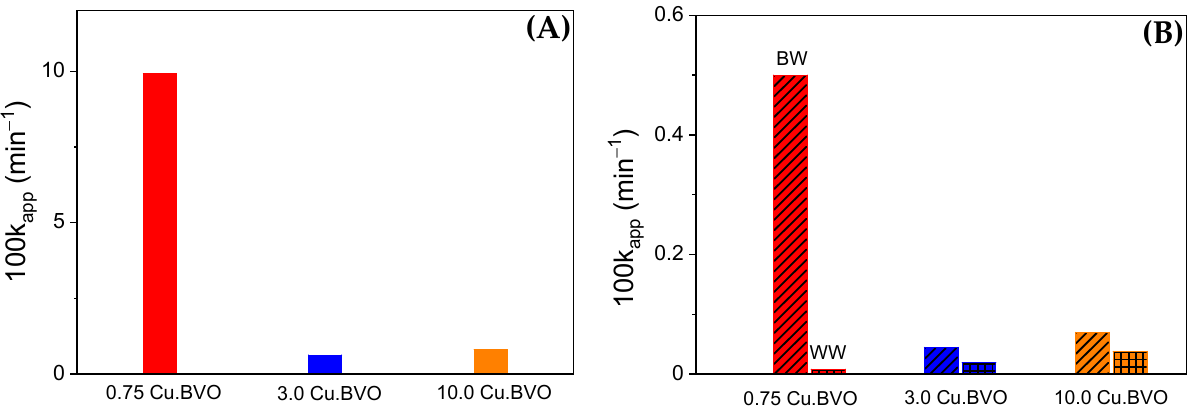
Figure 3. SEM images with EDS mapping of Cu of ( A , B ) 3.0 Cu.BVO, and ( C , D ) 0.75 Cu.BVO. HRTEM images of ( E ) 3.0 Cu.BVO and ( F ) pure BiVO 4 .